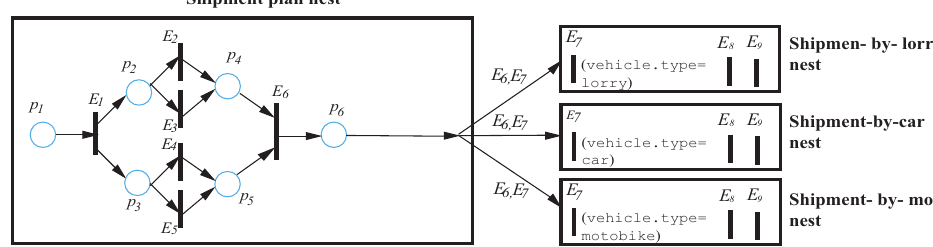
Figure 7. Hierarchical modeling of the courier